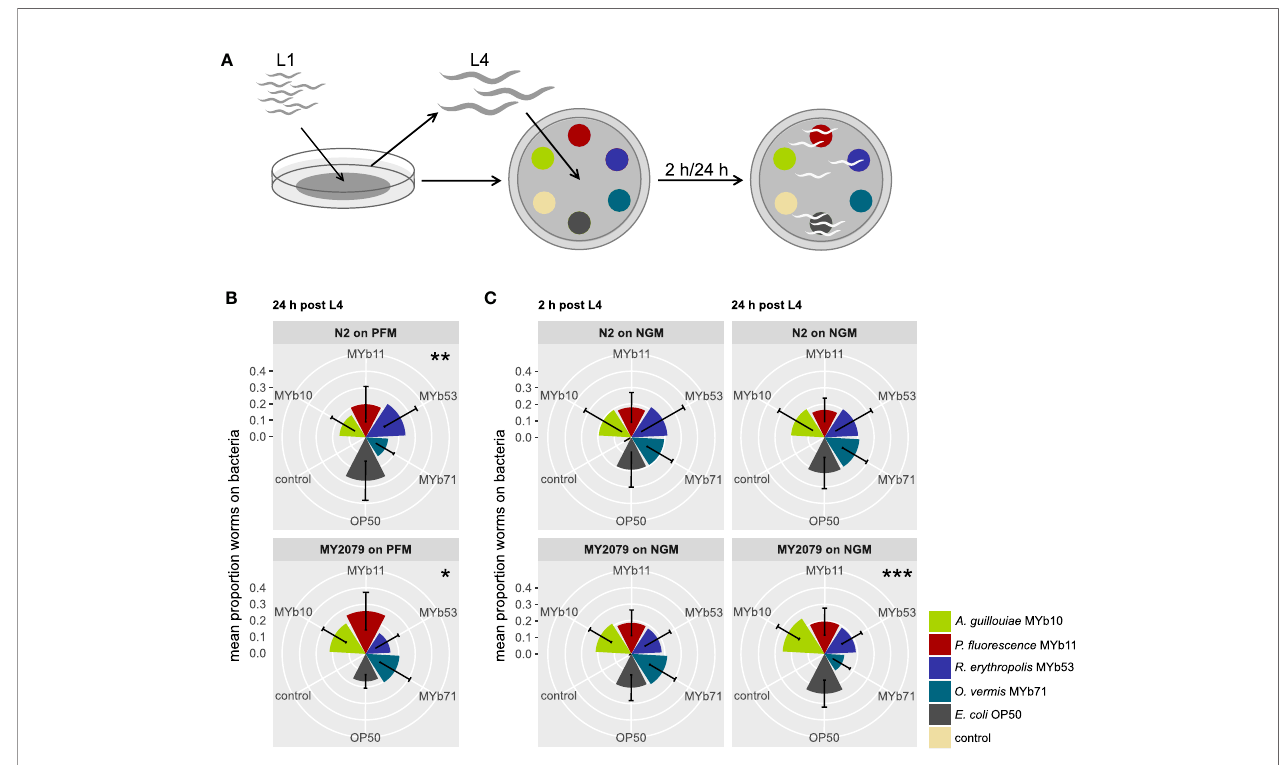
FIGURE 1 | Natural Caenorhabditis elegans isolate MY2079 alters its choice behavior on proliferating microbiota after 24h. (A) Synchronized C . elegans were grown on OP50 until L4 stage and then used in multiple-choice experiments. The choice behavior of C. elegans N2 and MY2079 was evaluated toward a subset of (B) non-proliferating microbiota on peptone-free medium (PFM) after 24 h and (C) proliferating microbiota on nematode growth medium (NGM) after 2 and 24 h post L4. Shown are means ± SD of n = 15 (with ~100 worms per n), Kruskal – Wallis (Kruskal and Wallis, 1952) with false discovery rate correction for multiple testing (Benjamini and Hochberg, 1995); asterisks indicate difference within the given treatment. Signi fi cance is designated to the following scale: *** p < 0.001, ** p < 0.01, * p <